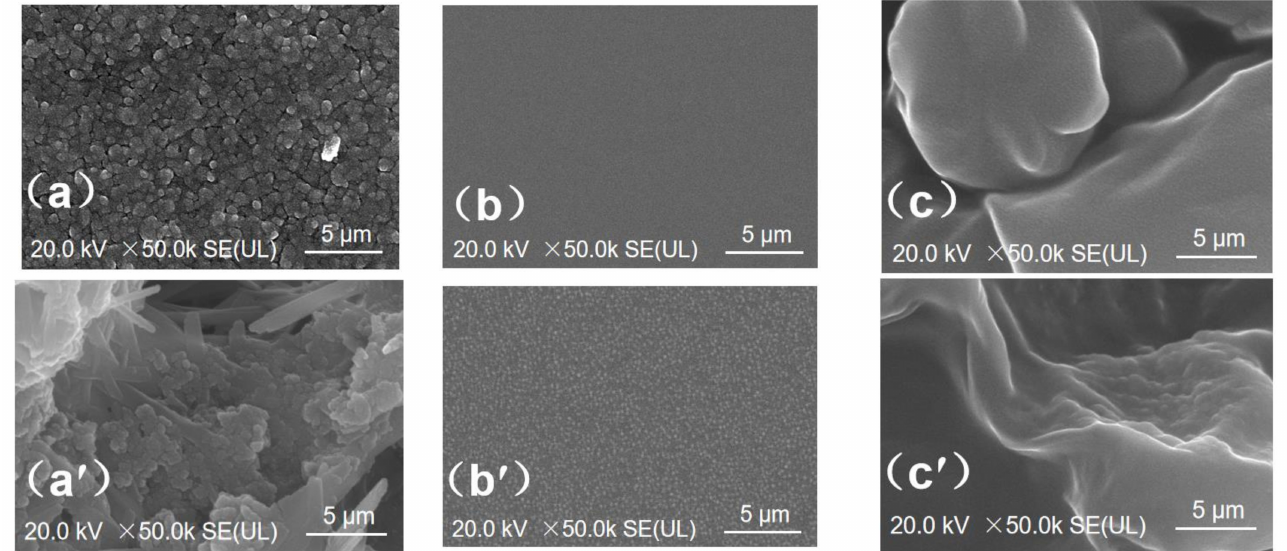
Figure 7. SEM images of specimen surface: ( a , a (cid:48) ) for specimen #1 before/after corrosion; ( b , b (cid:48) ) for specimen #2 before/after corrosion; ( c , c (cid:48) ) for specimen #3 before/after